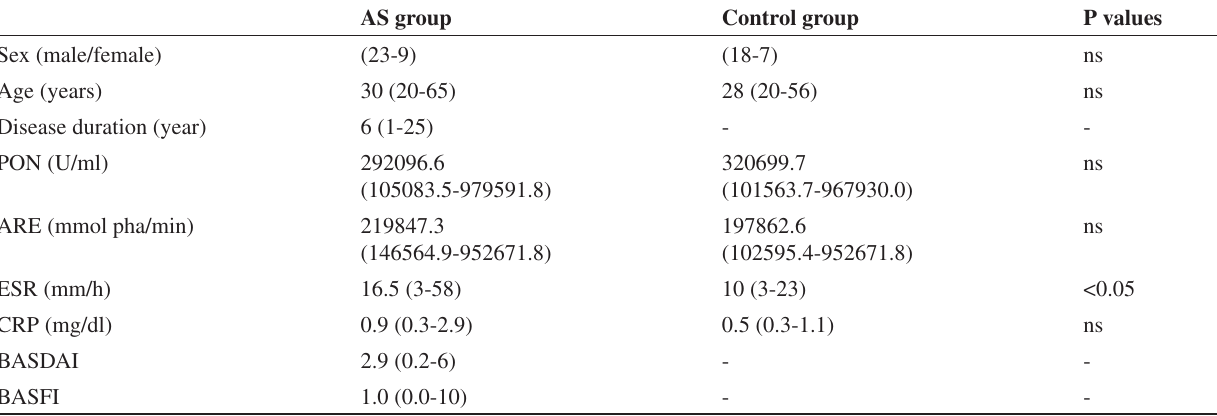
Table 1 - Demographic data as well as clinical and laboratory findings in patients with AS and healthy controls AS group Control group P